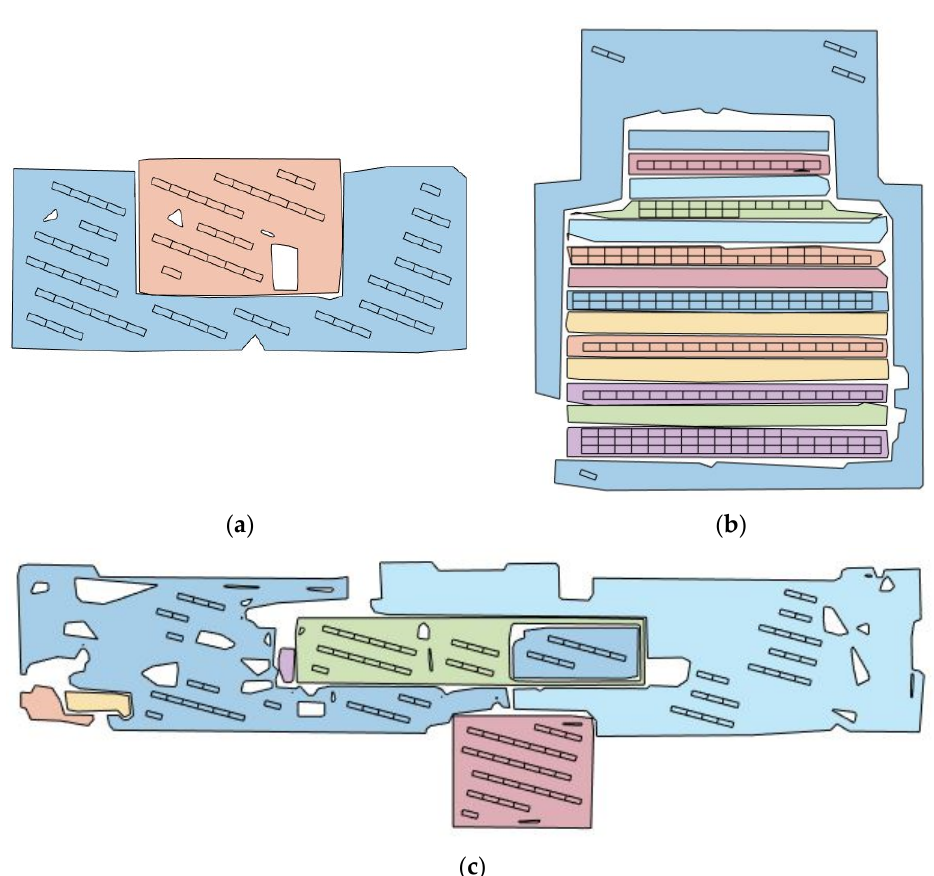
Figure 16. Optimum layout of PV systems for ( a ) the ADMIN building, ( b ) the CAM building, and ( c ) the EAS building.